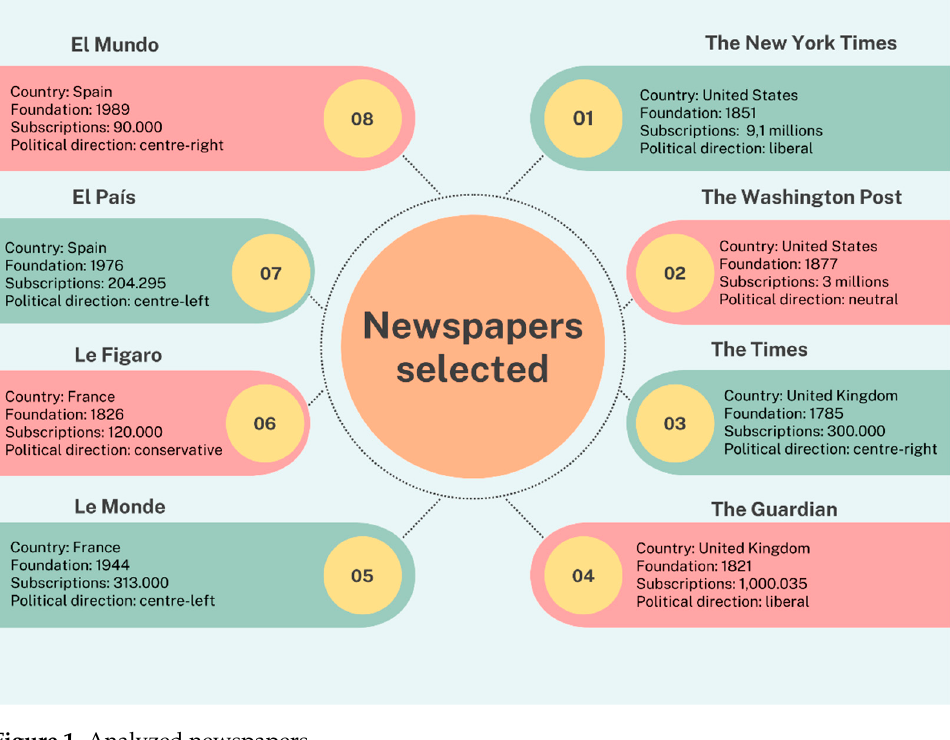
Figure 1. Analyzed